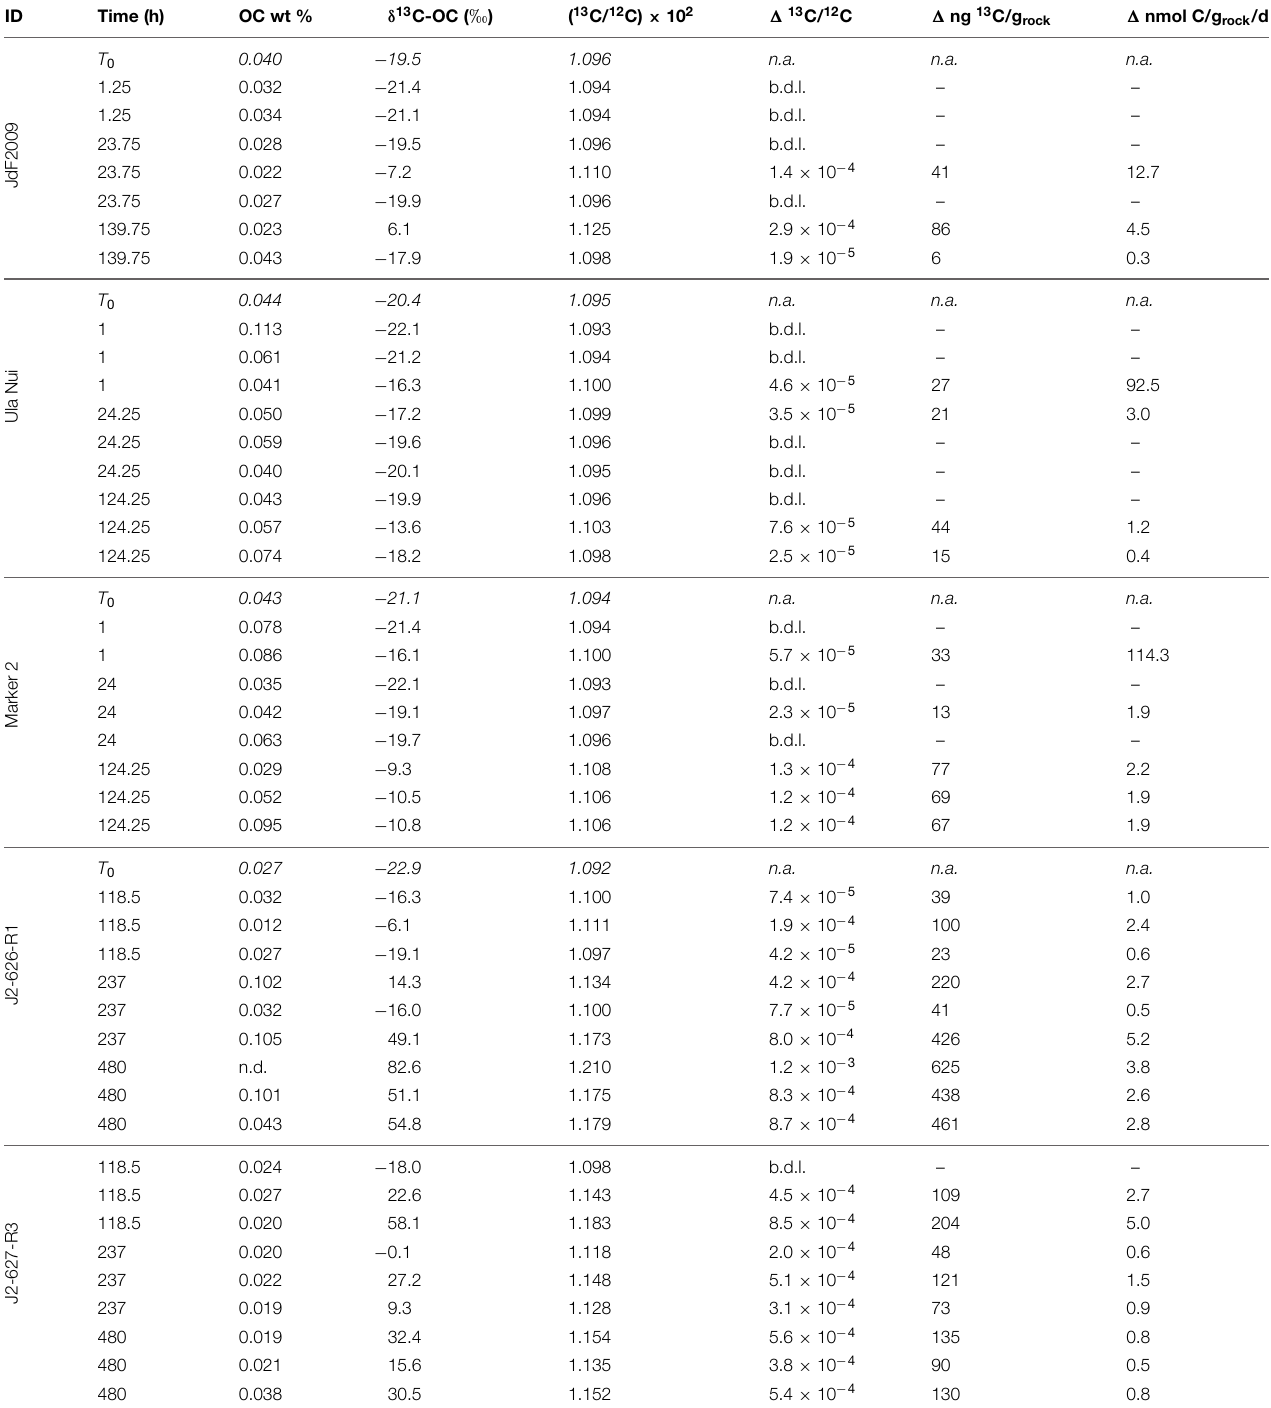
TABLE 3 | Summary of organic carbon content and stable carbon isotope composition of seafloor basalt samples after incubation.